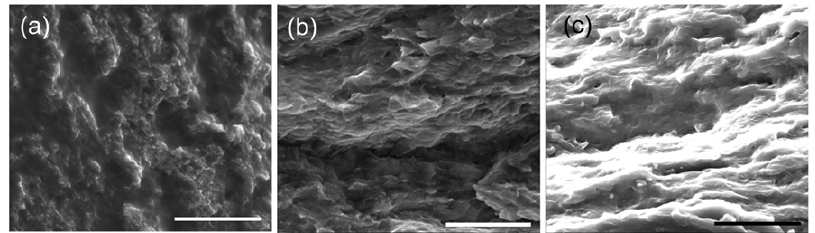
Figure 1. SEM images of cold fractured surfaces for samples with 20, 40, and 60-wt% SDBS (a, b, and c, respectively). These samples contain 20 wt% CNTs (99% purity). Fractures become sharp and disorganized as less surfactant is included, eventually forming heterogeneous structures as seen in (a). Scale bars indicate 10 m m.